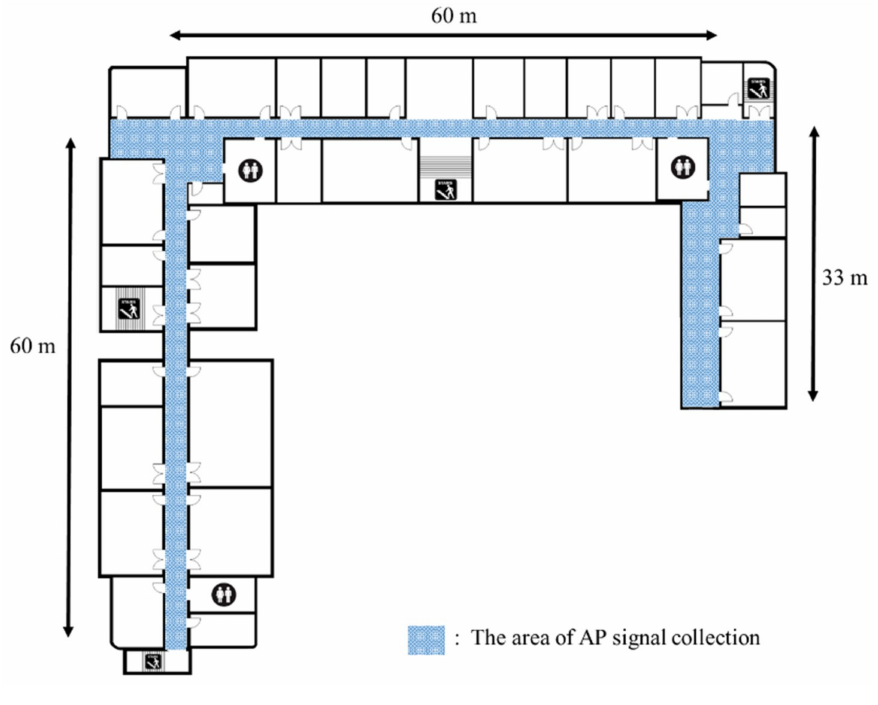
Figure 5. Experiment space to adapt the proposed algorithm.